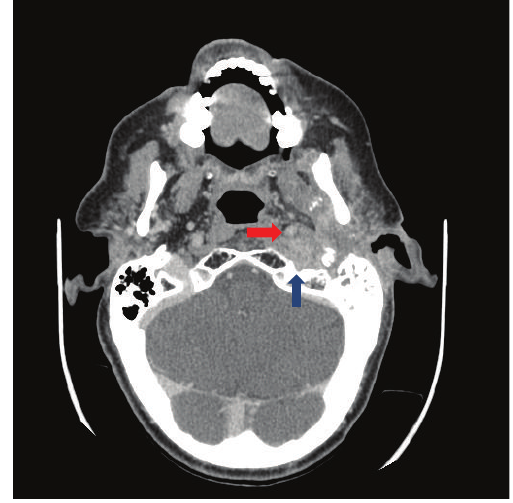
Figure 2: CT scan of the patient’s head, axial image. The red arrow shows tumor encasing the internal carotid artery. The blue arrow shows tumor infiltrating the skull base where CN IX exits the jugular foramen. CN IX is not visualized clearly because of the invading